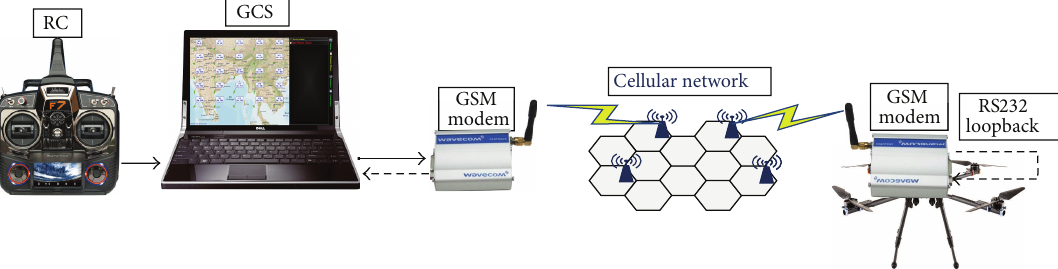
Figure 10: Experimental infrastructure for GSM delay measurements.